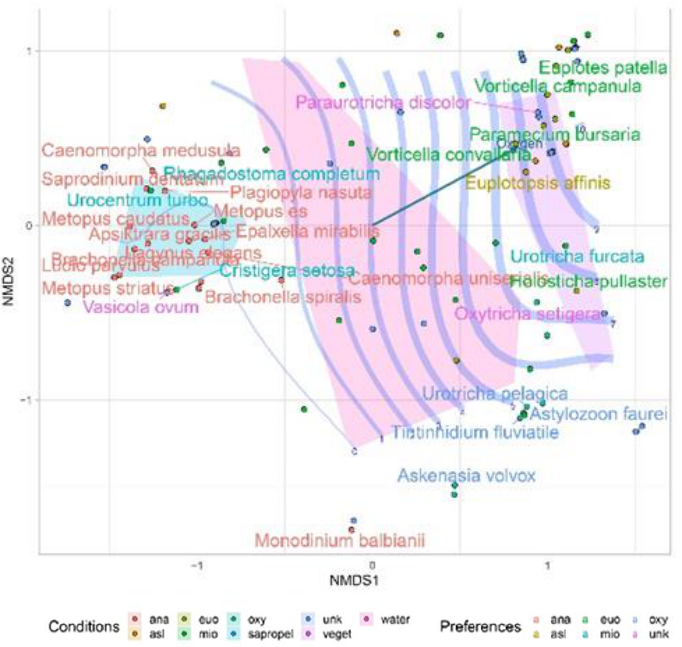
Figure 11. NMDS of habitats based on the abundance of ciliated species with superimposed oxygen gradient (isolines whose width is proportional to the O 2 concentration indicated next to the isoline). Only indicator species are shown. The areas occupied by the samples belonging to one of the three habitats − sapropel, water, and plants – are marked in color.